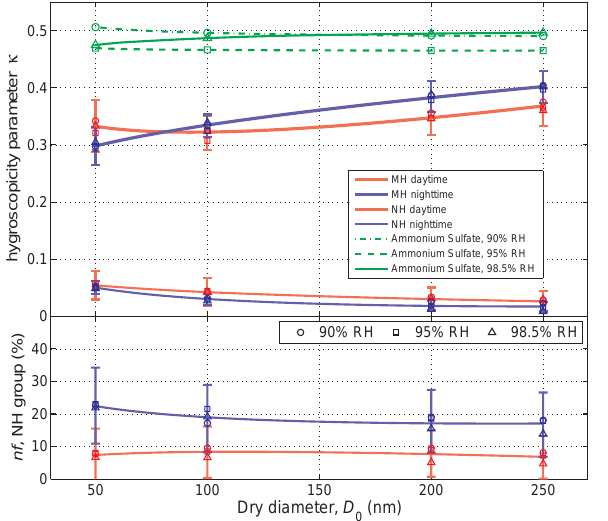
Fig. 7. Parameterization of κ and nf. The upper panel shows the parameterizations of κ as functions of dry diameter for more- hygroscopic group and nearly-hydrophobic group particles during the day and during the night, respectively; the lower panel shows the parameterizations of the number fractions of nearly-hydrophobic group particles.